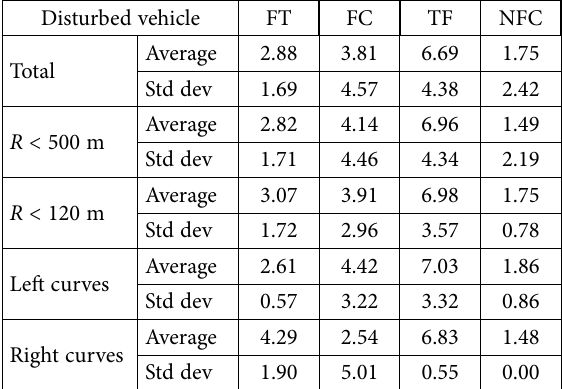
Figure 1. Relationship between geometric curve and duration of the glance on the internal edge of the curve